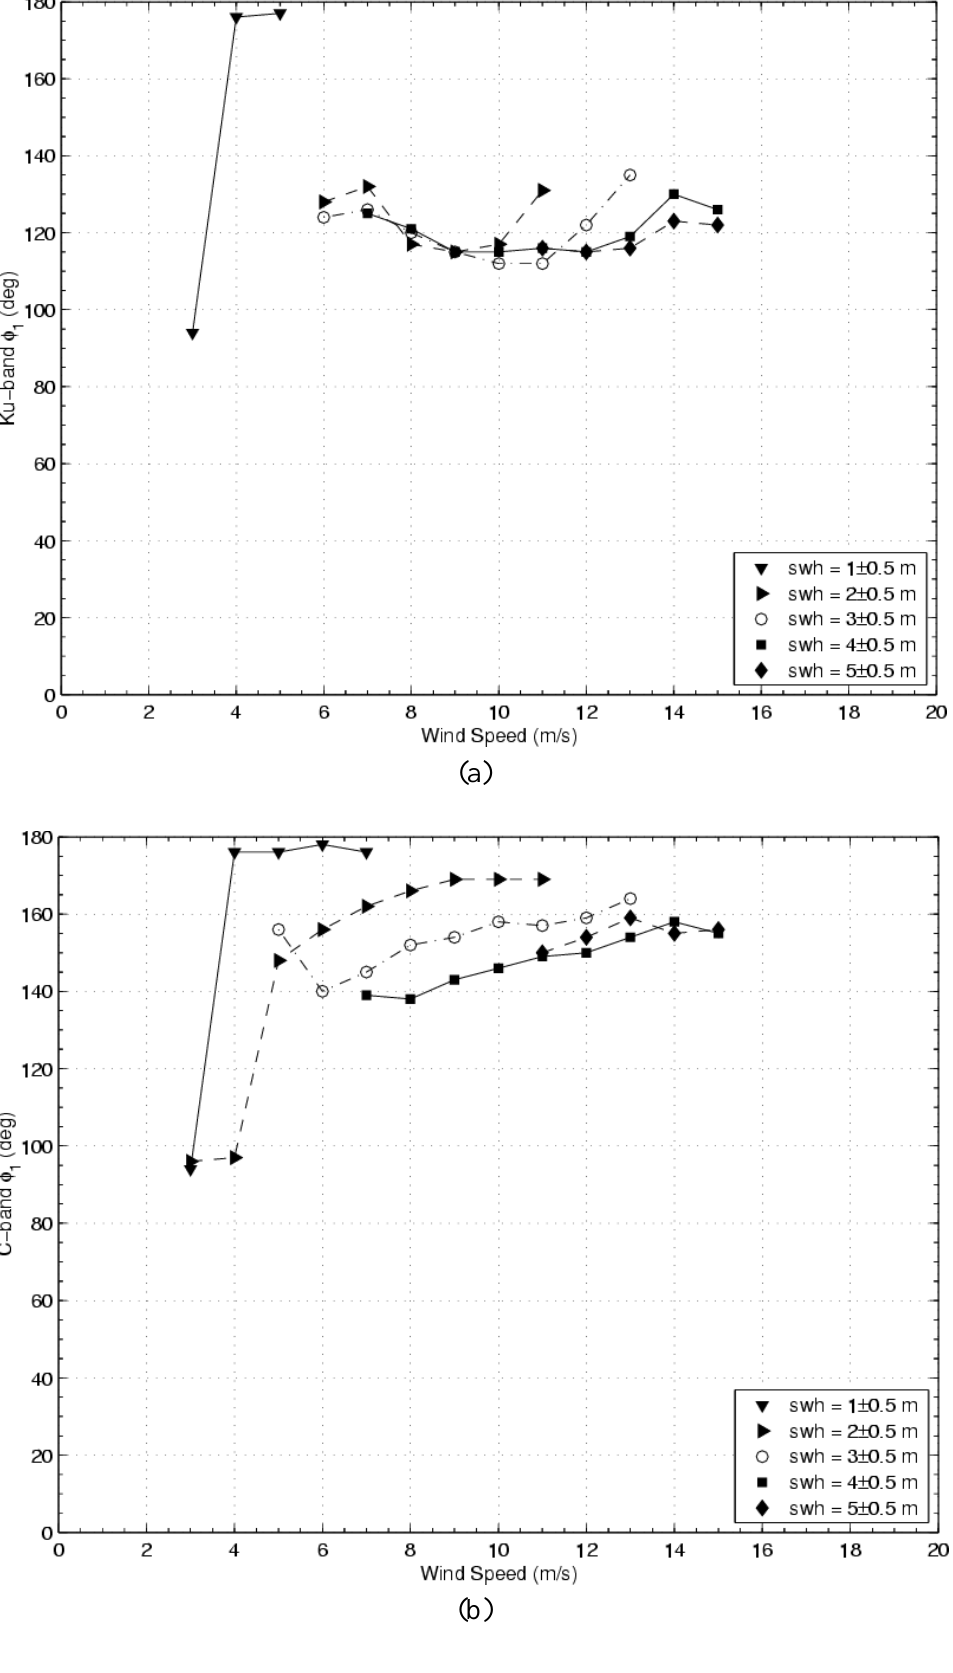
Figure 7. Same as Figure 4 for five different 1 m SWH classes (a) for Ku-band data and (b) for C-band